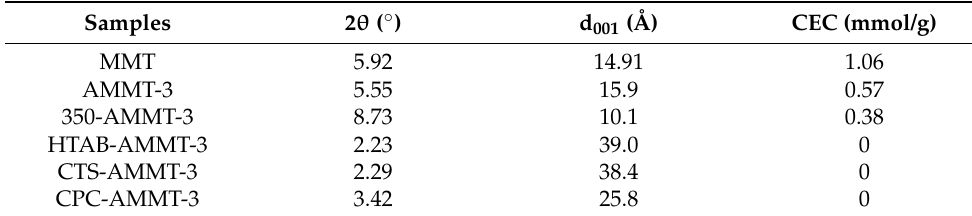
Figure 1. XRD profiles of raw MMT and modified montmorillonites. Figure 1 . XRD profiles of raw MMT and modified montmorillonites . Table 2. XRD data and CEC values of raw MMT and modified Table 2. XRD data and CEC values of raw MMT and modified montmorillonites.